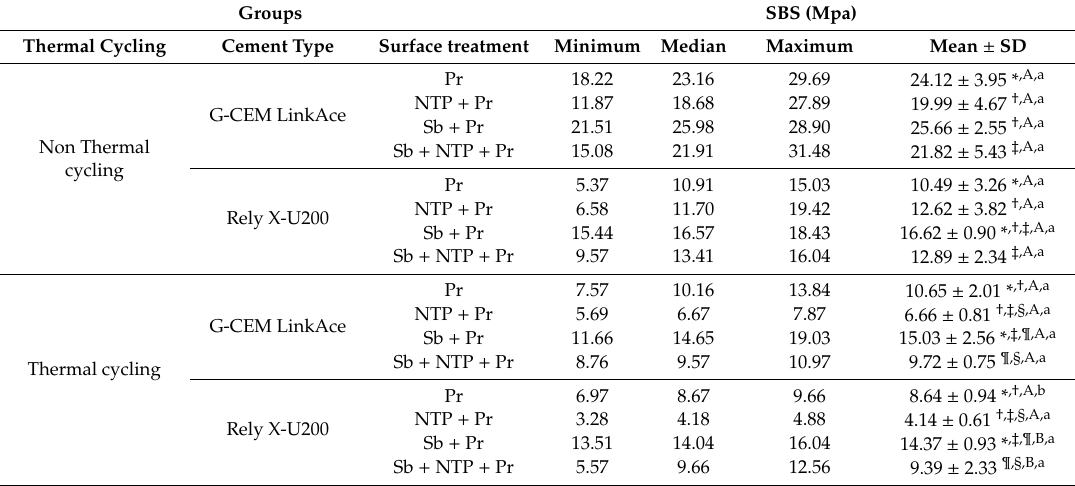
Table 4. Minimum, median, maximum, and mean shear bond strength values (MPa) and standard deviations (SD) for each